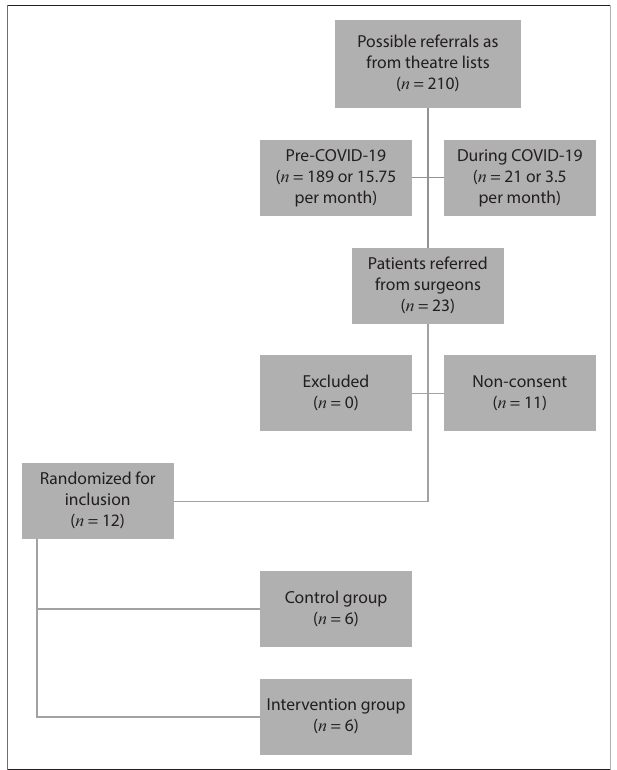
FIG URE 1: Number of participants and allocated